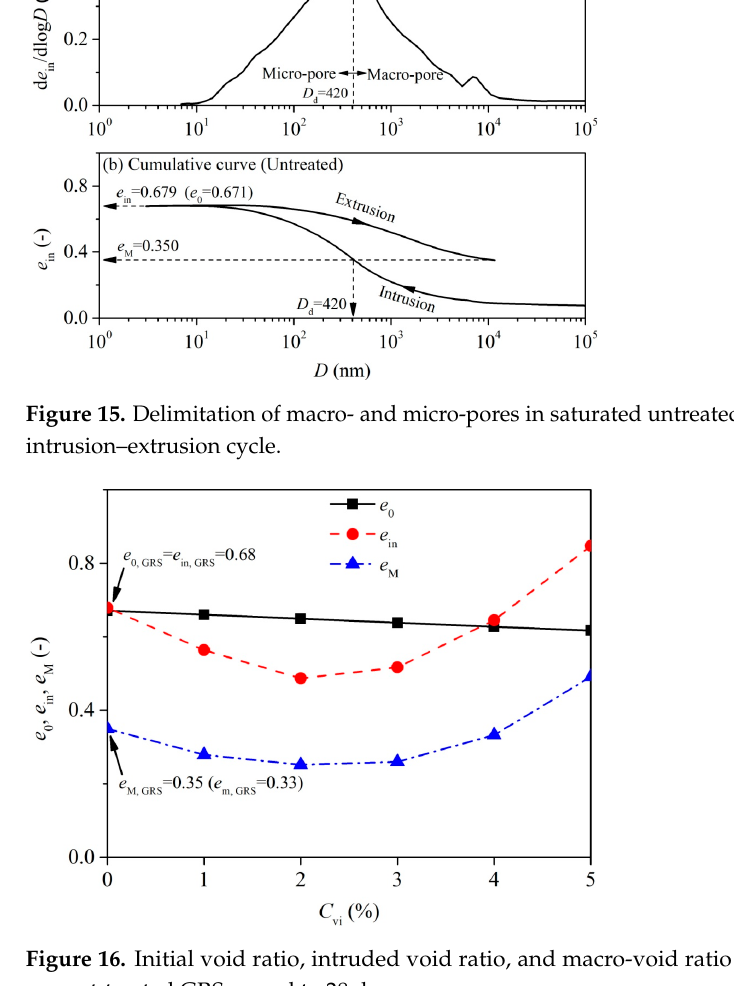
Figure 16. Initial void ratio, intruded void ratio, and macro-void ratio of saturated untreated and cement-treated GRSs cured to 28 d.